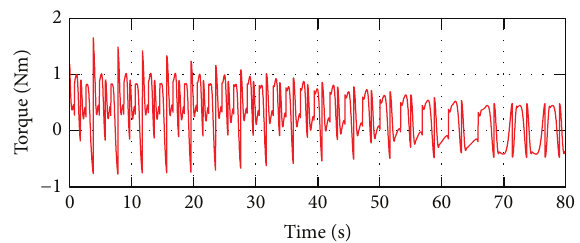
Figure10:Timeevolutionsofthekineticenergy 𝐸 𝑘 andthepotential energy 𝐸 𝑝 .